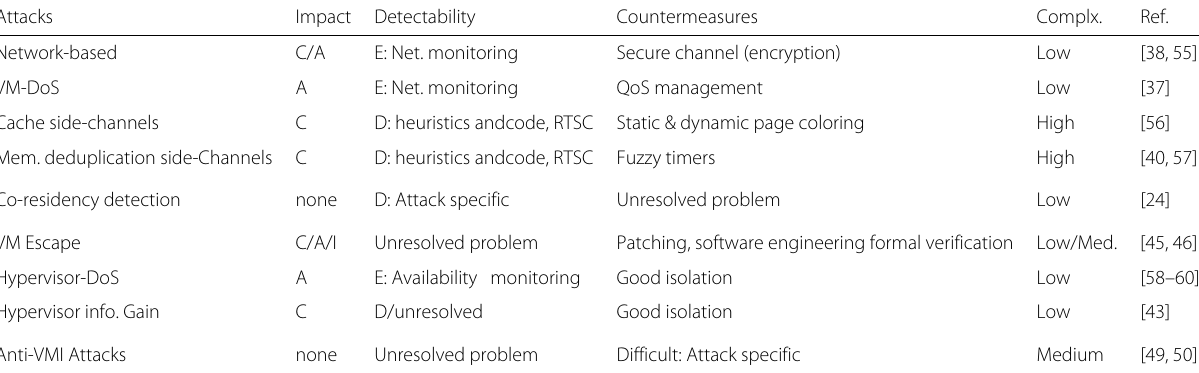
Table 4 Characterization of the different attacks originating from VMs Attacks Impact Detectability